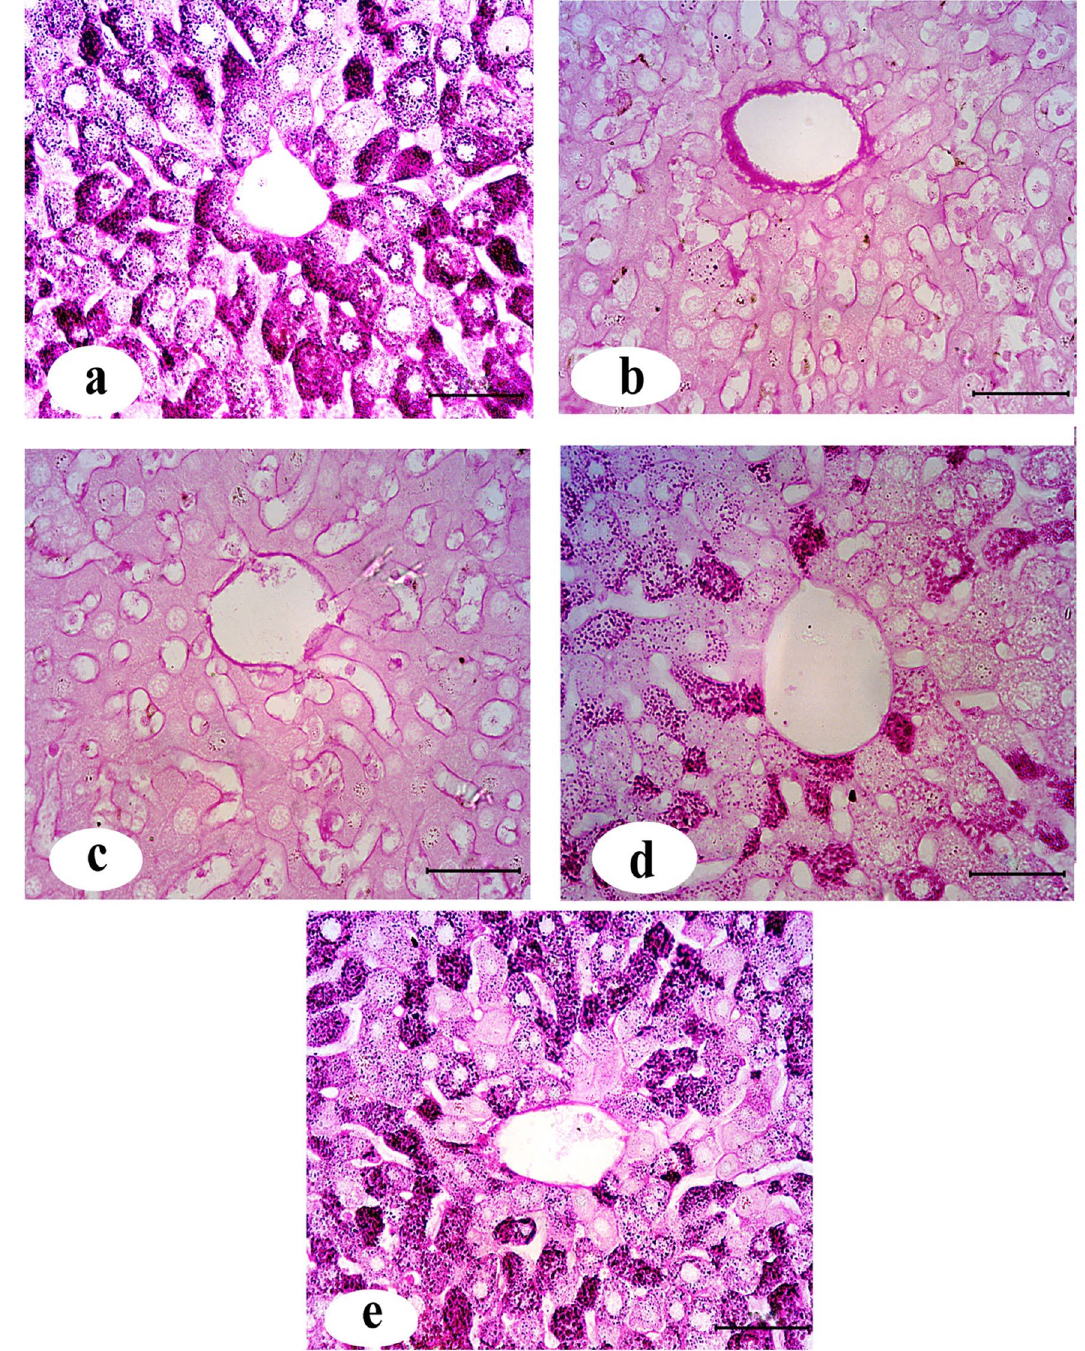
Figure 10. (a ) High magnification image of liver from a control dense glycogen deposits. (b and c) AC group, showing marked glycogen depletion. (d) AC + Cur group, showing improved glycogen contents. (e) AC + NCur group, showing near-control levels of glycogen (PAS stain Bar = 50